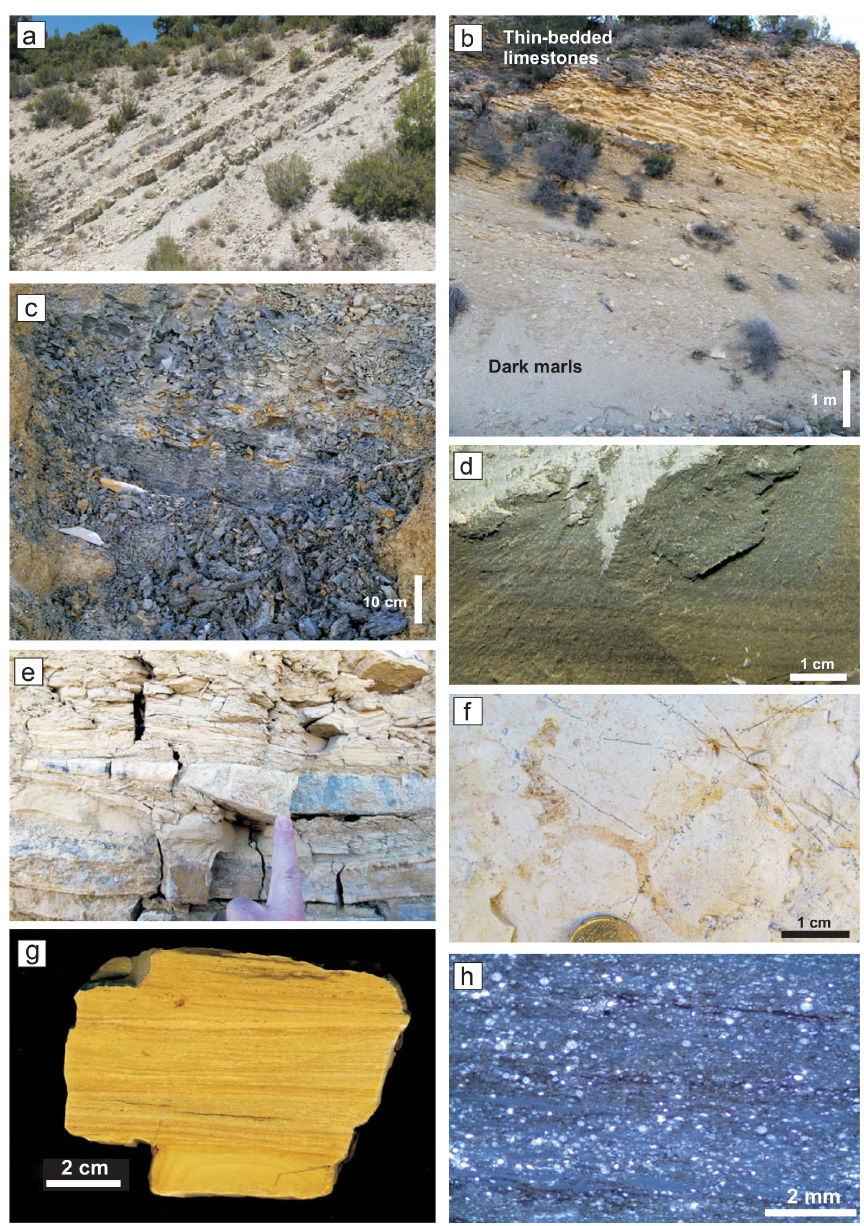
Figure 2. Facies and microfacies of the Cueva del Agua section. (a) Field view of the alternating marls and marly limestone in the Emaciatum Zone (upper Pliensbachian). (b) Contact between Toarcian dark marls and thin-bedded limestones. (c) Detailed view of the dark marls of the Polymorphum–Serpentinum Zone boundary. (d) Close view of the thin-laminated dark marls of the base of Serpentinum Zone. (e) Thin- bedded limestones of the Serpentinum Zone. (f) Trace fossil from the wall of a calcisiltite bed of the thin-bedded limestone. (g) Polished slab from the thin-bedded limestone showing lamination. (h) Microfacies of the thin-bedded limestones with laminae constituted by